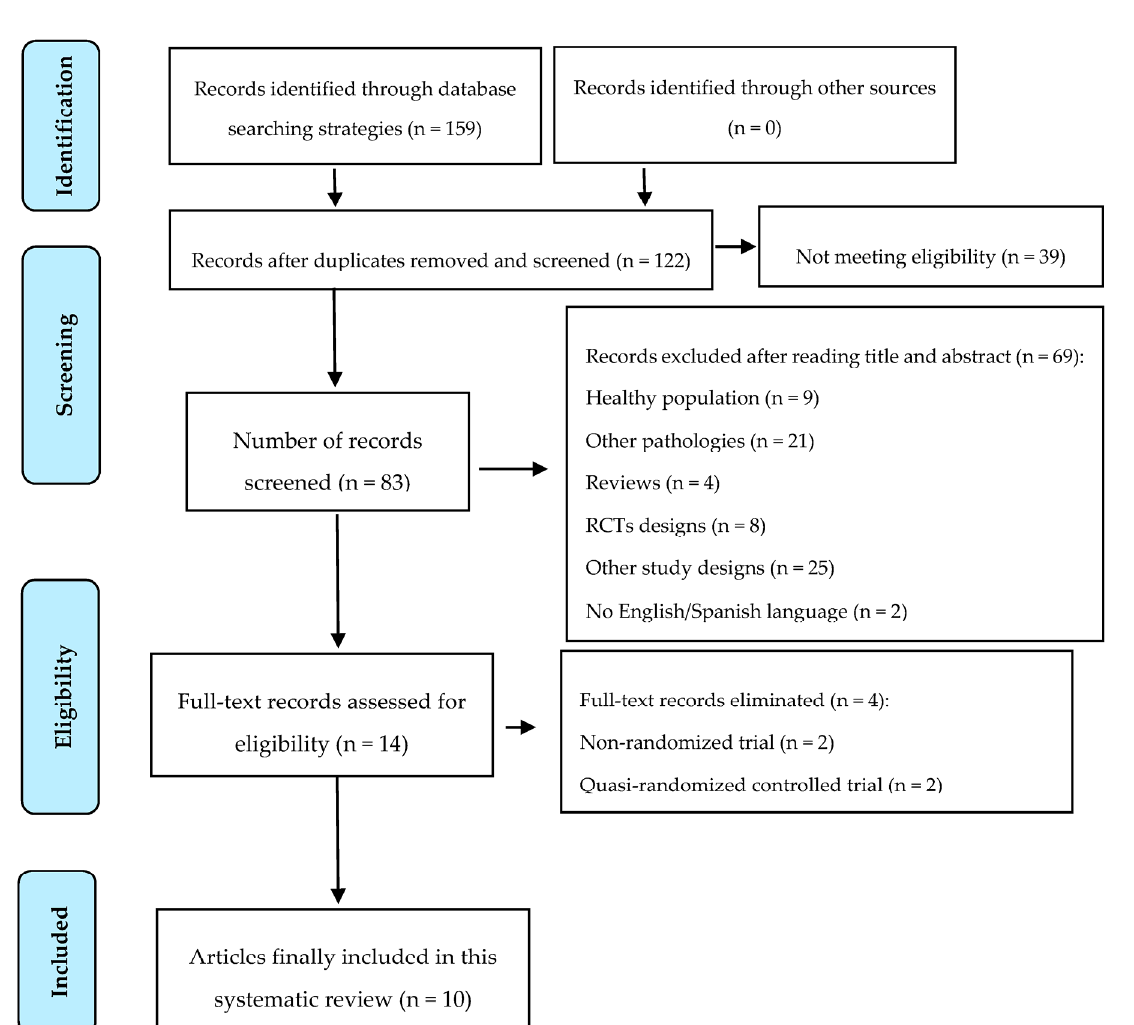
Figure 1. Preferred Reporting Items for Systematic Reviews and Meta-Analyses (PRISMA) flowchart diagram of the search process [20].